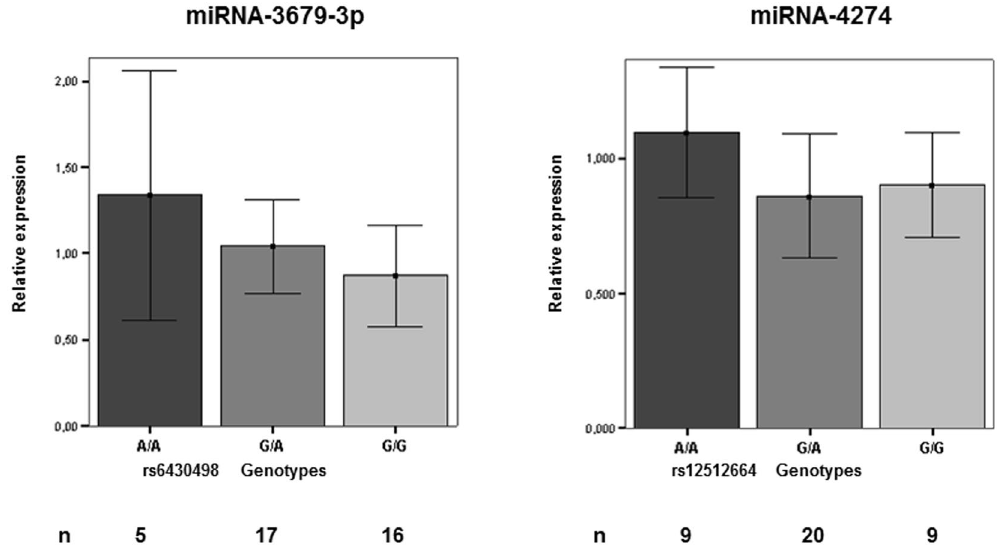
Figure 3. Correlation between miRNA expression levels and genotypes for miR-3679 and miR-4274. MiRNA expression levels are represented as a mean ± SD of the relative expression in Real-Time PCR. U6 was used for normalization. Samples of 38 human primary osteoblasts were used for experiments. (n) is the number of samples for each genotype